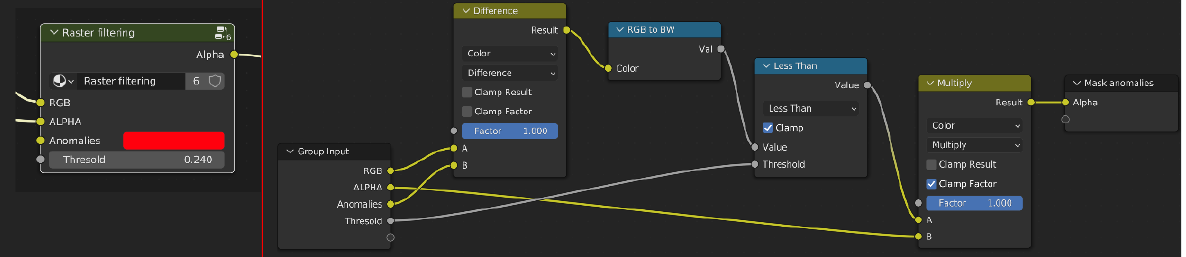
Figure 11. Detail of the data filtering algorithm (node group on the left, exploded algorithm on the right) starting with the input RGB data, a possible prior alpha channel (in this case, the raster clipping, diagonal to the original tiff image), a reference color for the peak value of the anomaly to be highlighted, and a threshold to reduce or increase filtering.